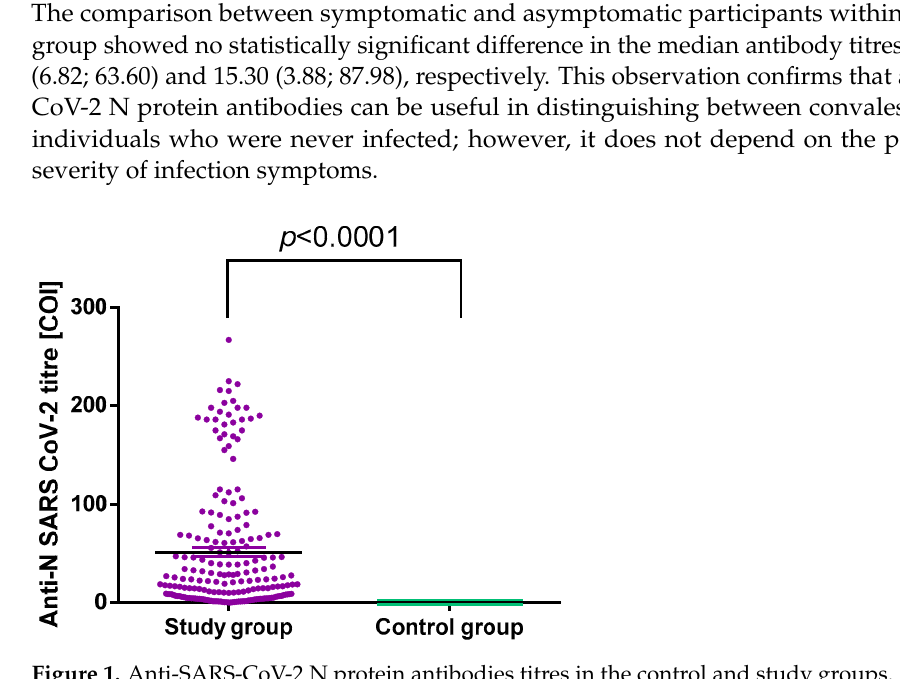
Figure 1. Anti-SARS-CoV-2 N protein antibodies titres in the control and study groups.